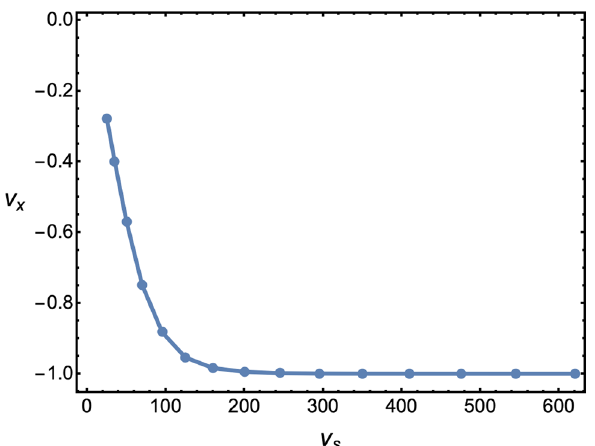
Fig. 7 The final apparent velocity minus the speed of the bubble as a function of the speed of the bubble, measured in a remote observer. The dust particle starts at rest at x = 2.5, y = 0, and the parameters of the bubble are R = 2, v s = 20, and σ = 10. All numerical values are in natural units. The center of the bubble is placed at x = 0 at